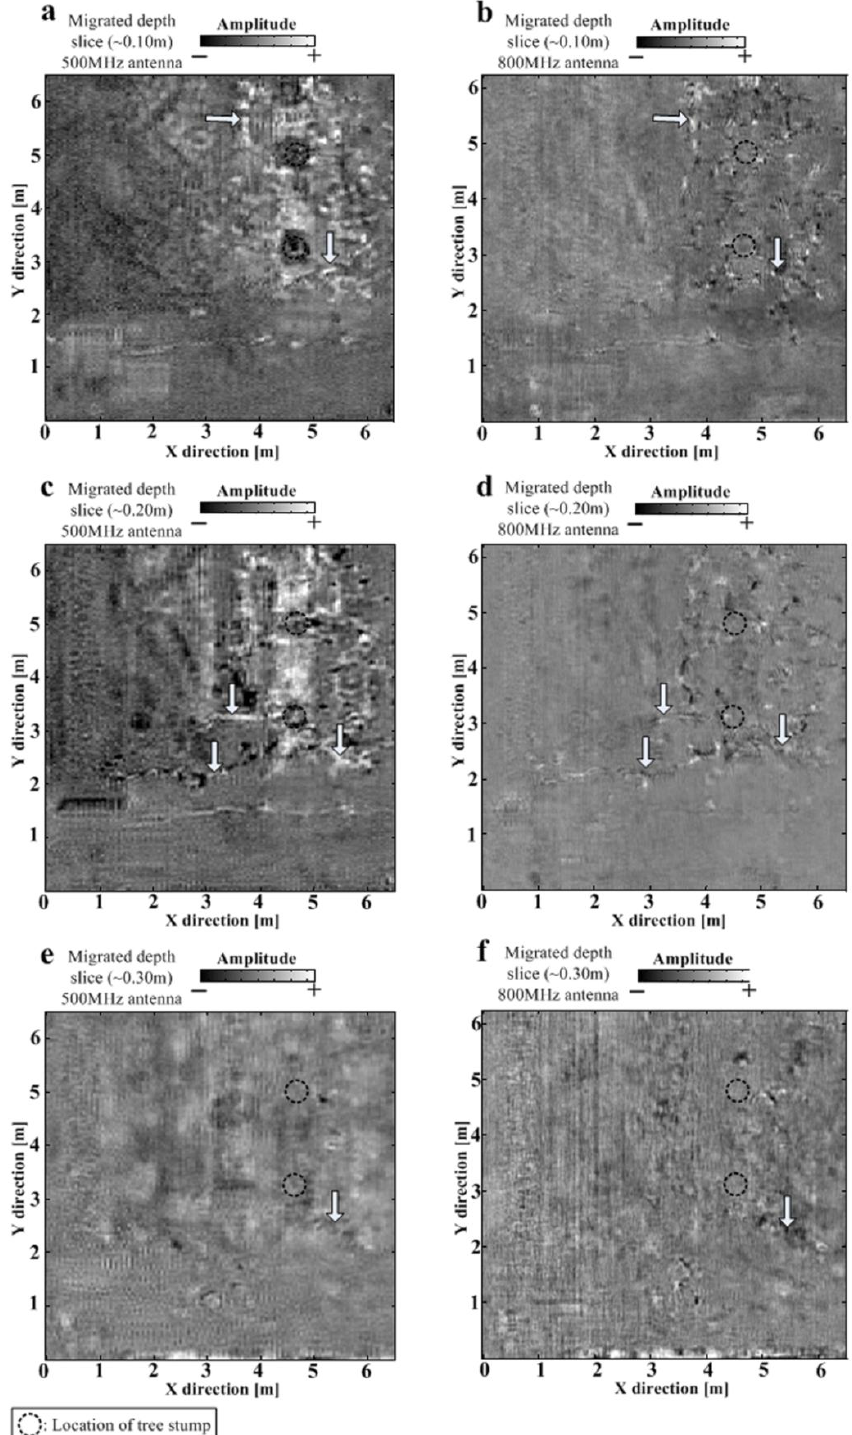
Figure 4. Different horizontal slices extracted from the 3D migrated cube at the different depths. ( a , b ) Migrated slices at 10 cm depth using the 500 MHz and 800 MHz antennas, respectively; ( c , d ) Migrated slices at 20 cm depth using the 500 MHz and 800 MHz antennas, respectively; ( e , f ) Migrated slices at 30 cm depth using the 500 MHz and 800 MHz antennas, respectively. White arrows indicate the reflections from the roots in the migrated data set, and black dotted circles show the locations of the tree